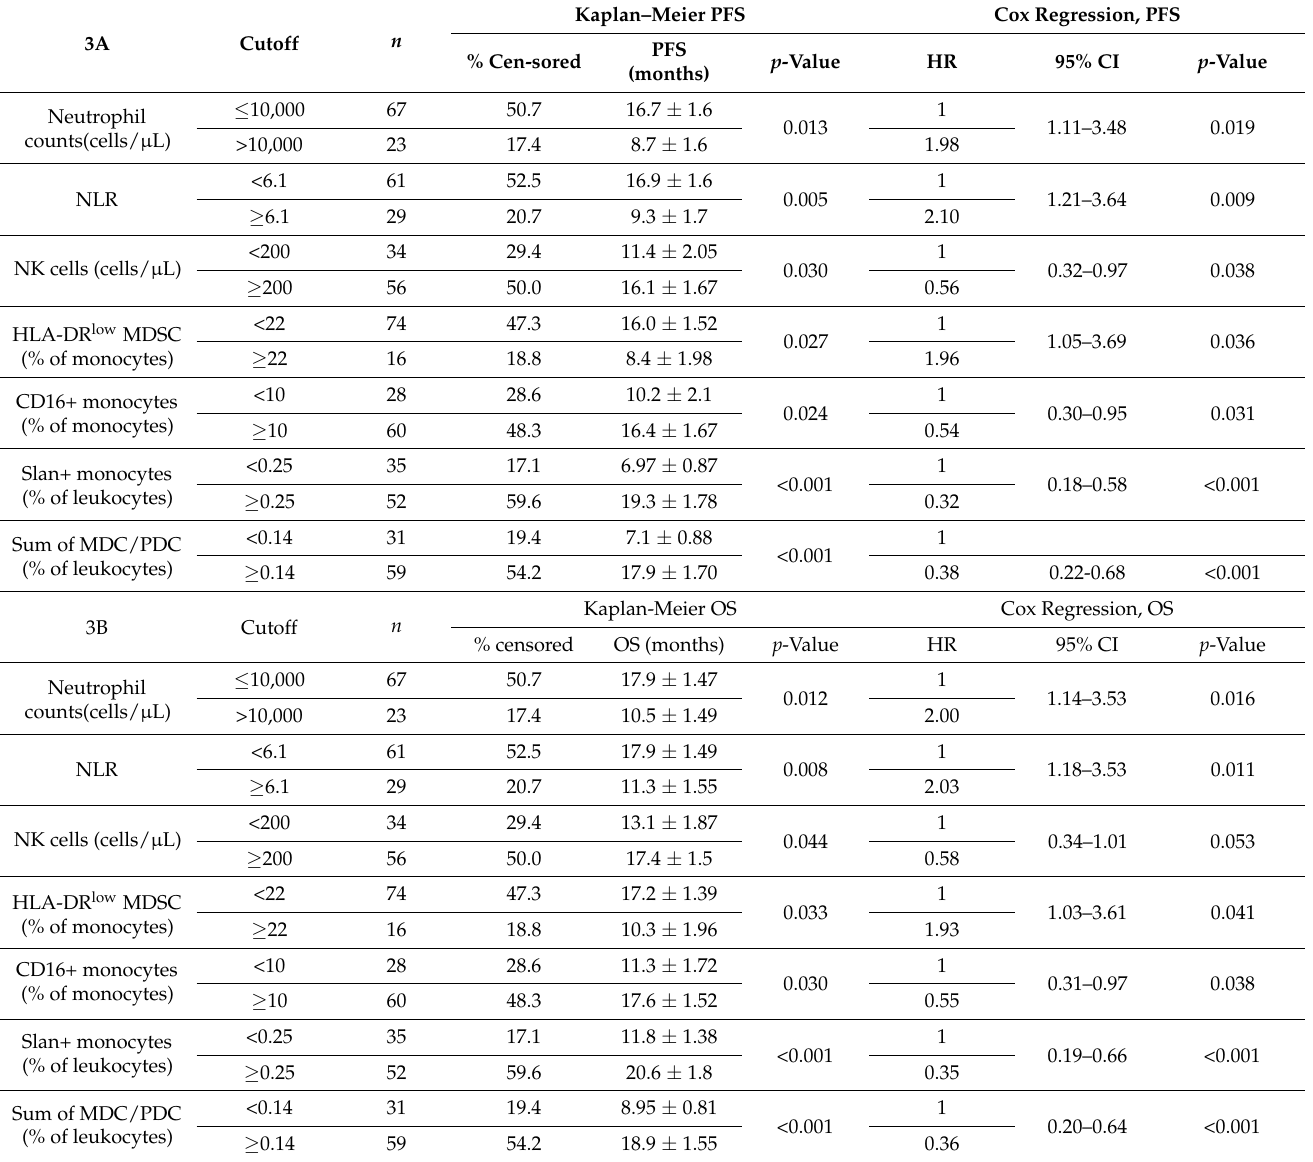
Table 3. Relationship between baseline blood immune cell parameters with patients’ survival (3A PFS; 3B OS). Data of univariate prognostic factor analysis is provided, with estimated mean of survival ± standard error, hazard ratios (HR) with 95% confidence interval (CI) and p